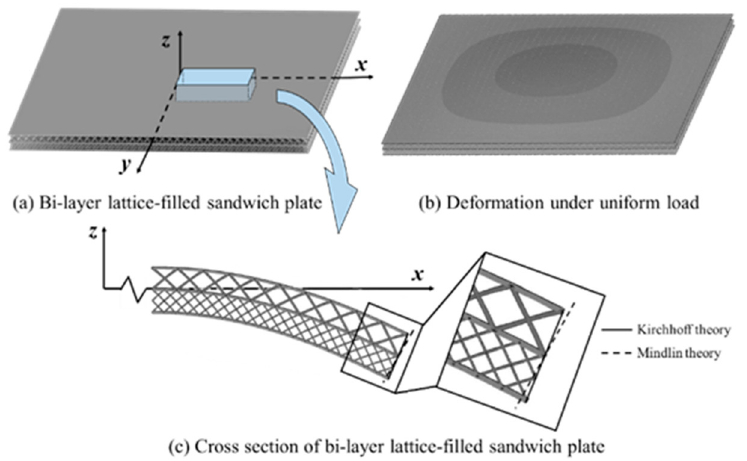
Figure 4. Deformation mode of Bi-layer lattice-filled sandwich plate under uniform load.